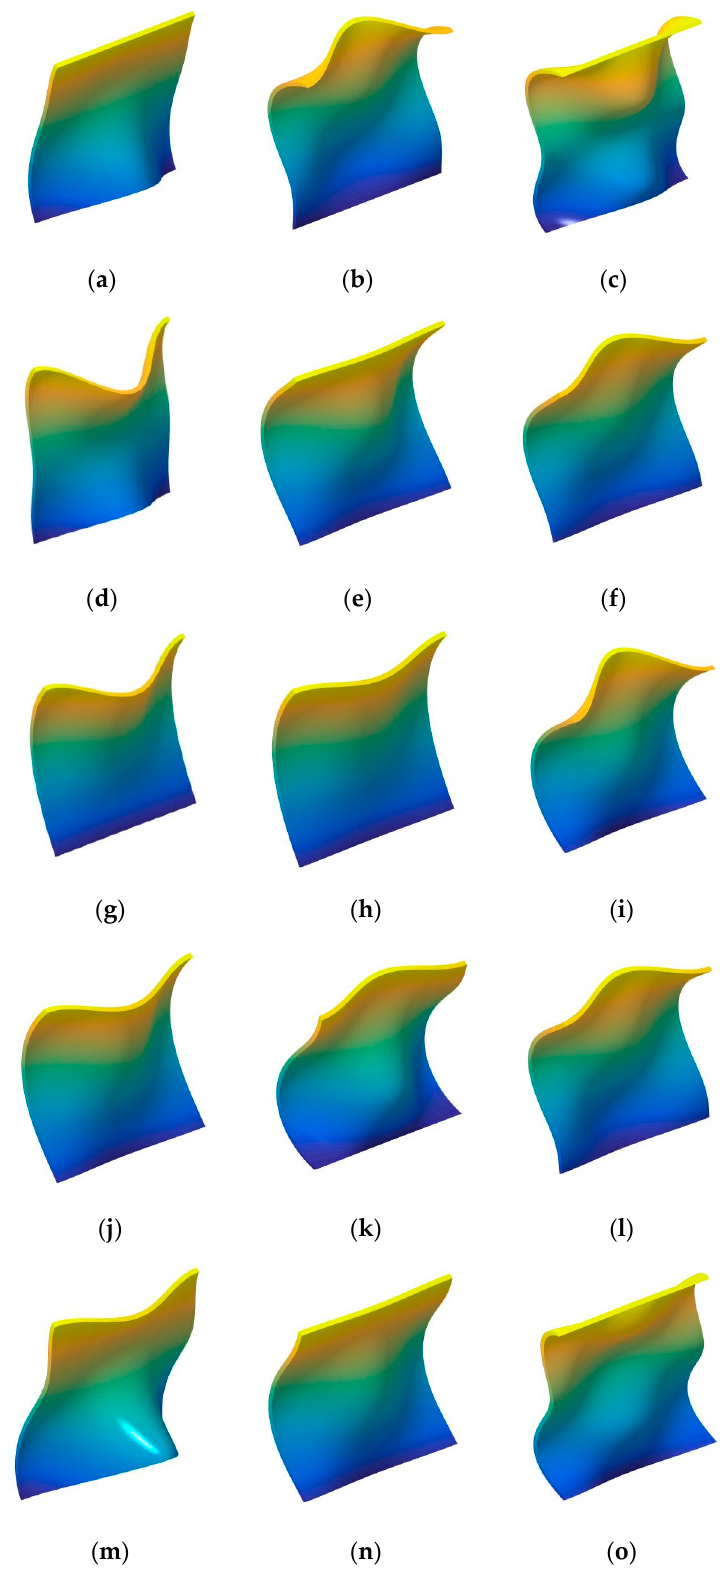
Figure 2. The mode shapes for the composite laminated shallow cylindrical shell with various boundary conditions. ( a ) C-C,(1,1); ( b ) C-C,(1,2); ( c ) C-C,(1,3); ( d ) F-C,(1,1); ( e ) F-C,(1,2); ( f ) F-C,(1,3); ( g ) F-F,(1,1); ( h ) F-F,(1,2); ( i ) F-F,(1,3); ( j ) F-S,(1,1); ( k ) F-S,(1,2); ( l ) F-S,(1,3); ( m ) S-C,(1,1); ( n ) S-C,(1,2); ( o ) S-C,(1,3).